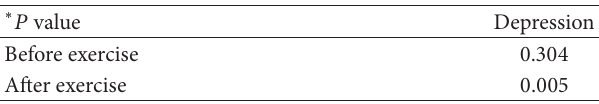
Table 6: The result of 𝑡 -test among exercise and control group in